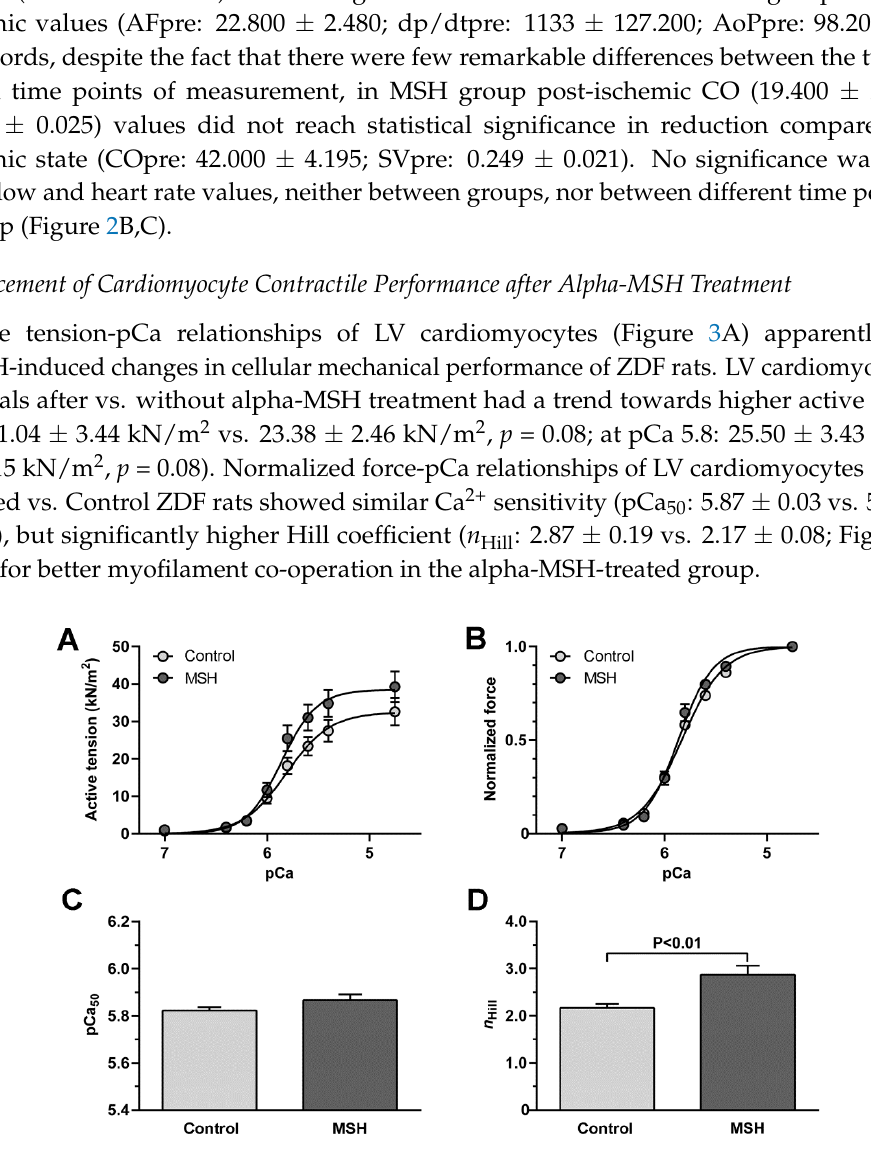
Figure 3. Enhanced contractile performance of left ventricular cardiomyocytes following alpha-MSH treatment. ( A ) Active tension-pCa relationships; ( B ) Normalized force-pCa relationships; ( C ) Half-value of Ca 2+ sensitivity curves on Panel B indicates myofilament Ca 2+ sensitivity (pCa 50 ); ( D ) Steepness of Ca 2+ sensitivity curves on Panel B indicates myofilament co-operation as Hill coefficient ( n Hill ). Data are given as mean ± SEM, whereas n = 12 cardiomyocytes (from 3 to 4 hearts)/groups. P values were calculated by unpaired t -test and shown when p < 0.05.